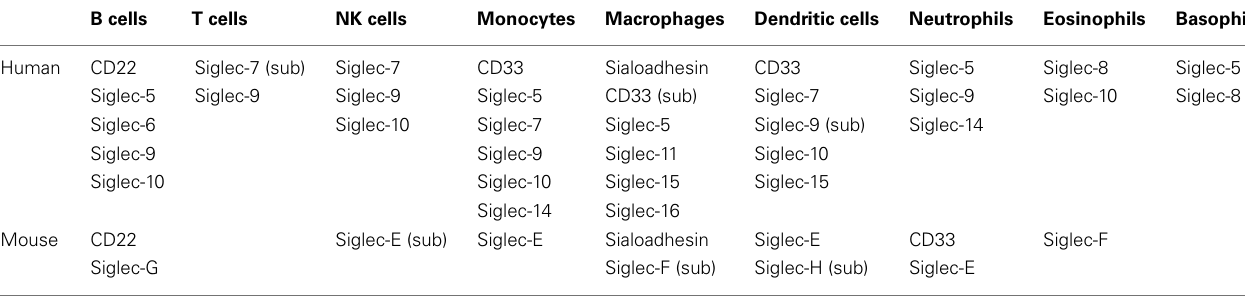
Table 1 | Expression pattern of murine and human Siglecs on the cells of the immune system. B